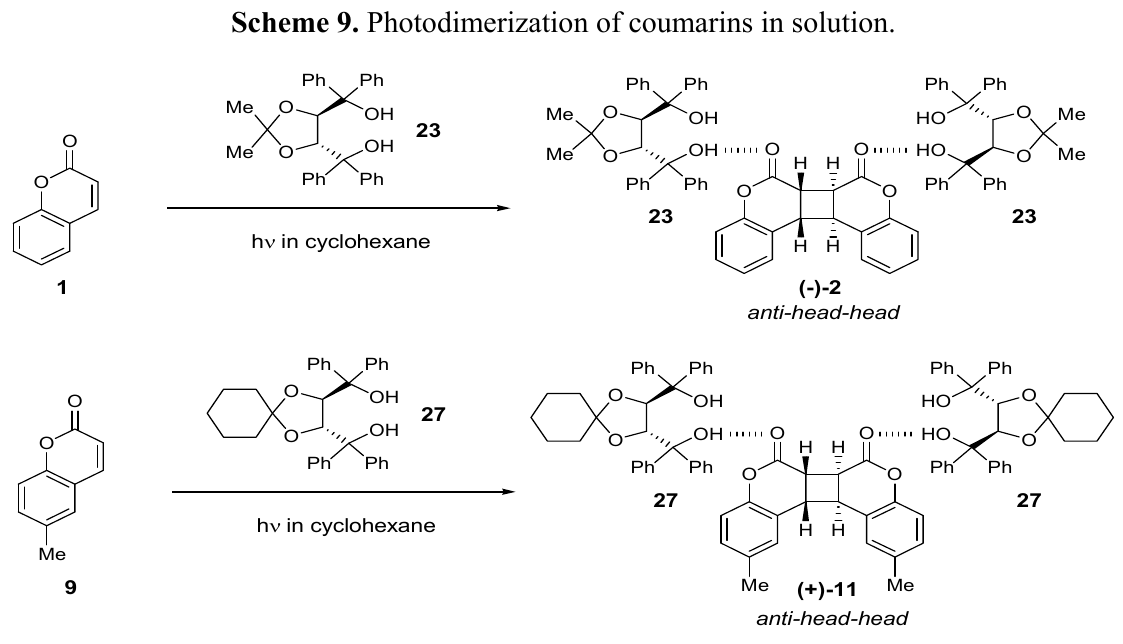
Figure 4. X-ray structure of the 2:1 complex of ( − )- 27 and the optically active anti–head–head dimer (+)- 11